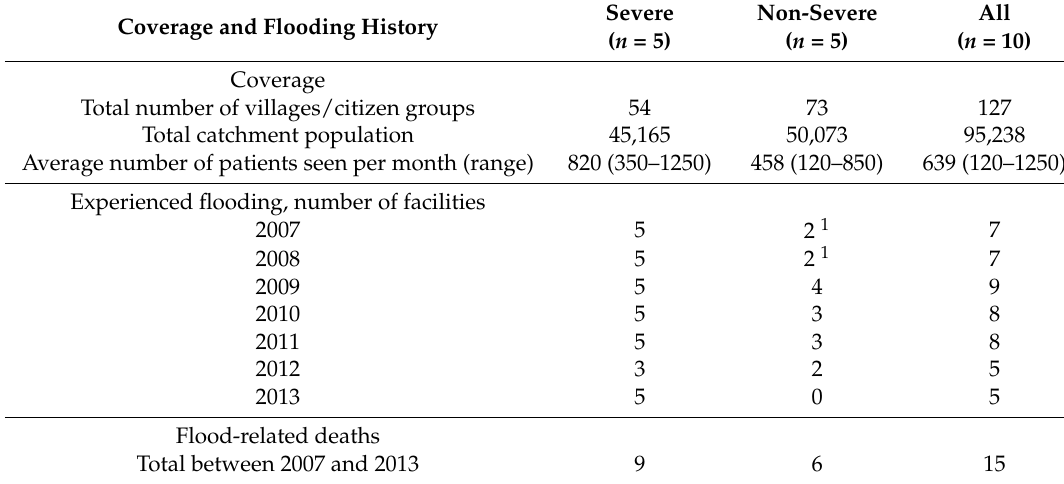
Table 1. Coverage areas and history of recent flooding among severely and non-severely flooded primary health care